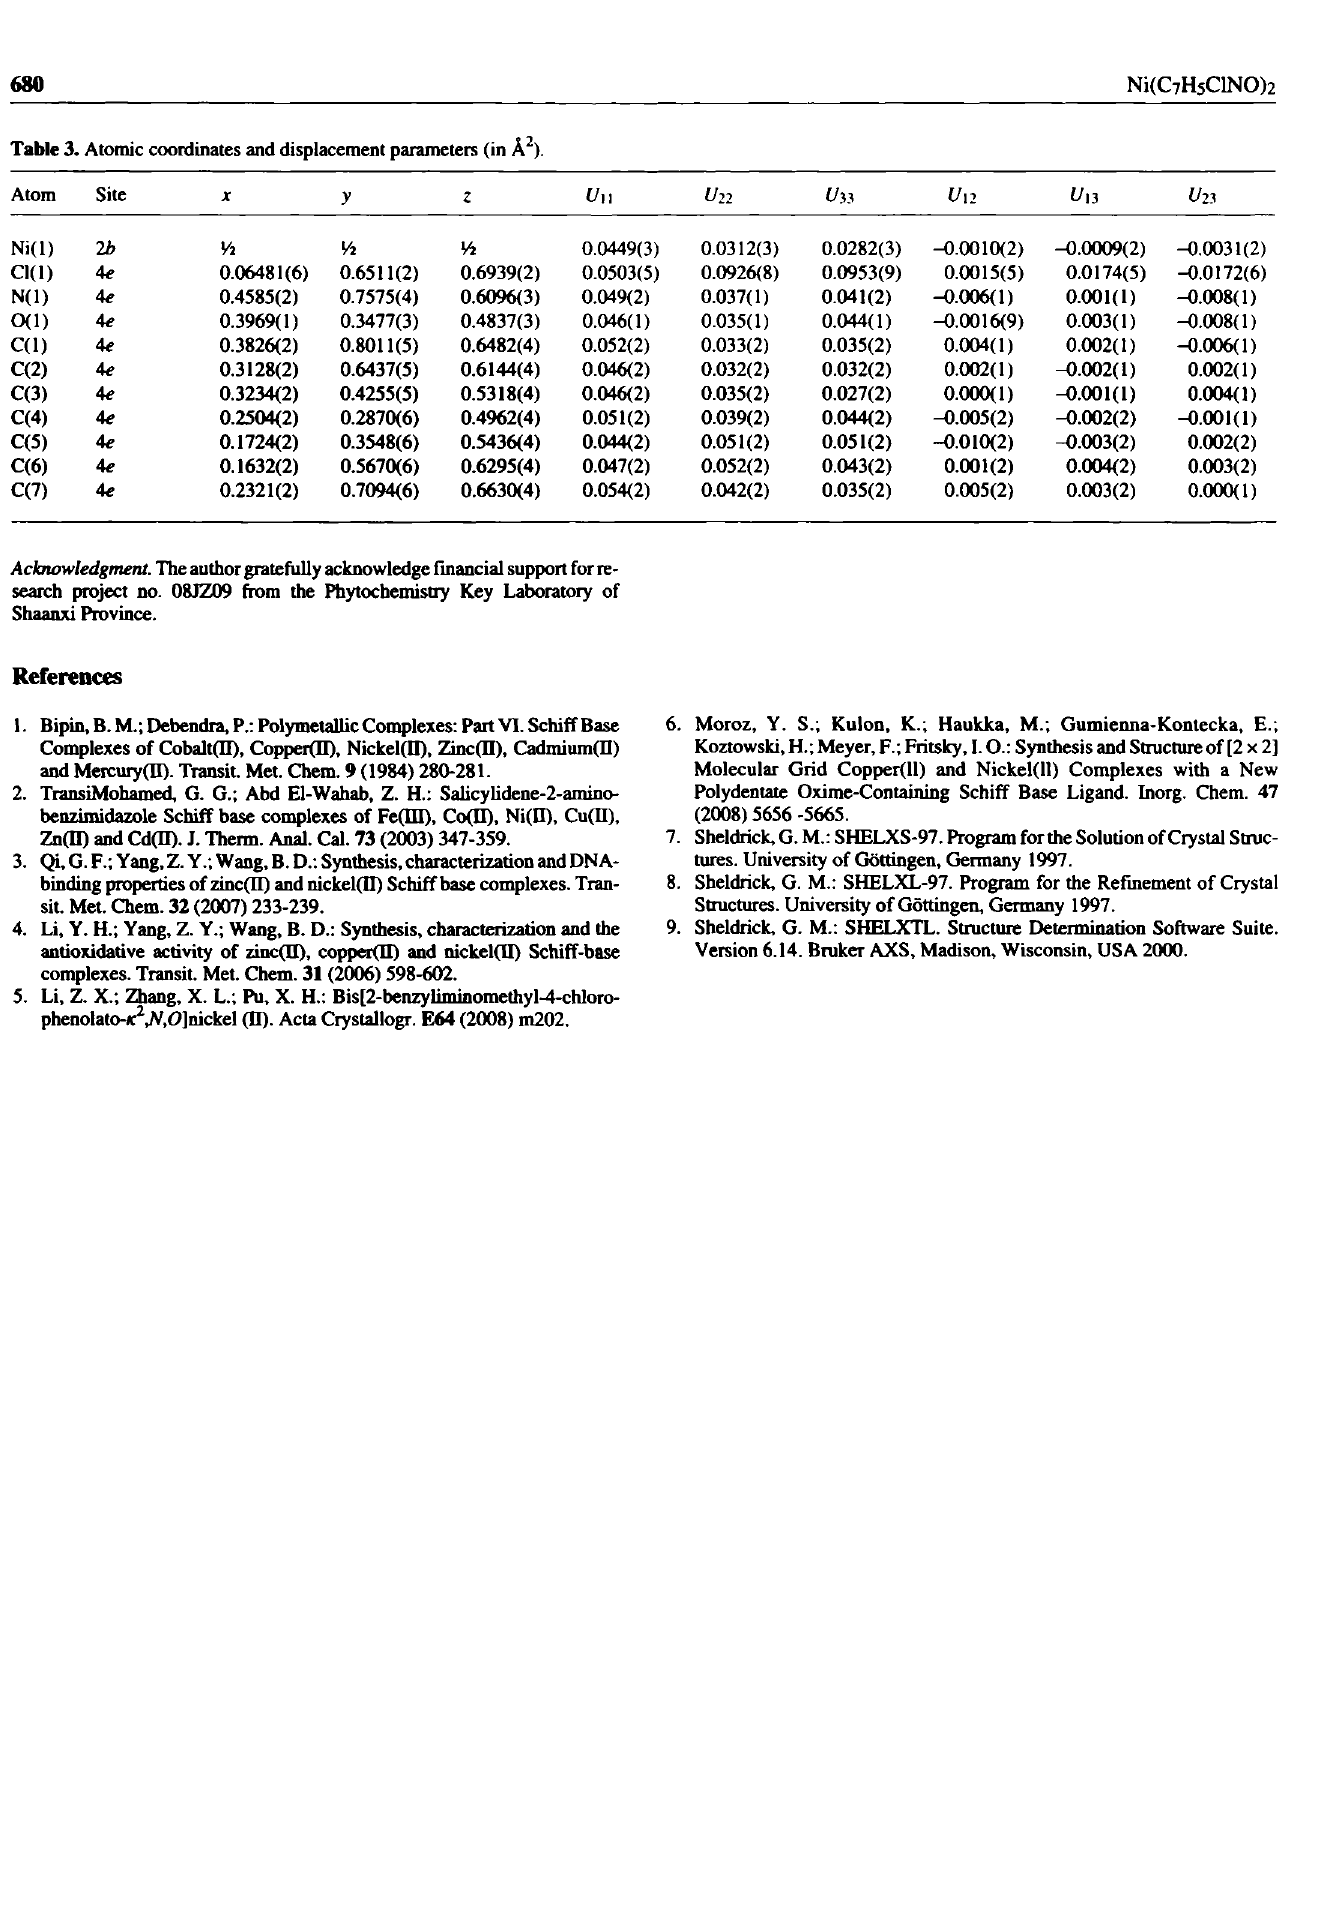
Table 3. Atomic coordinates and displacement parameters (in Â 2